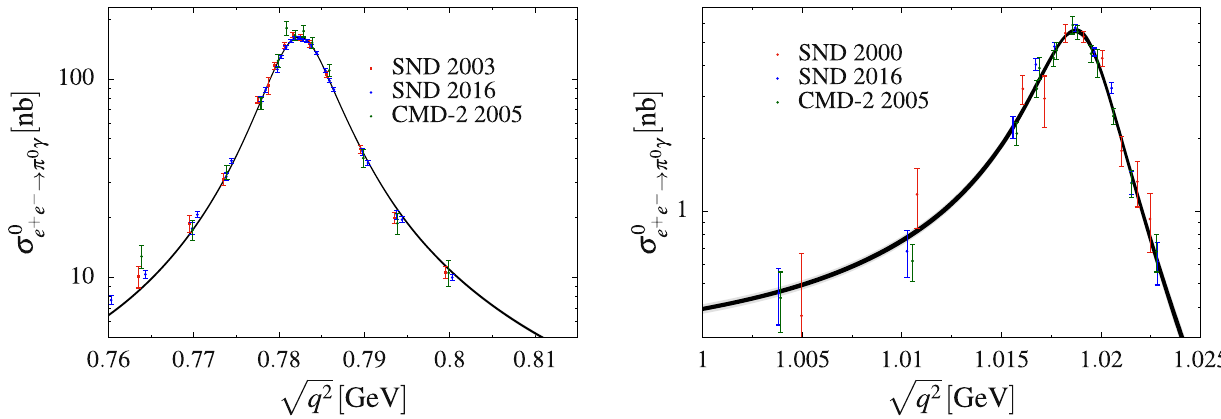
Fig. 2 Fit around the ω and φ resonance regions. The black band represents the fit uncertainties, and the gray band indicates the total uncertainty